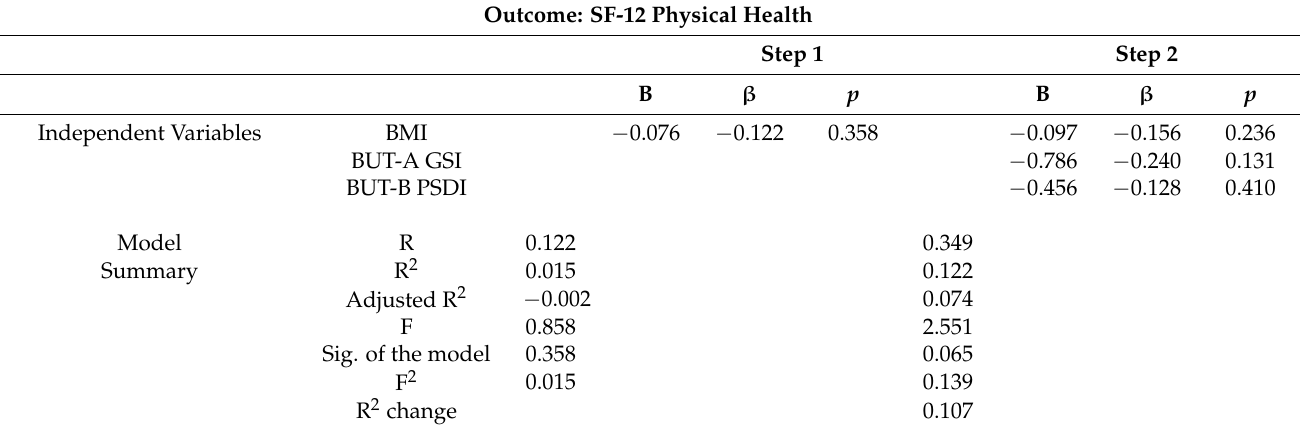
Table 5. Third hierarchical regression models including two steps, with BMI as predictor in first step; BMI, BUT-A GSI, and BUT-B PSDI as predictors of SF-12 Physical Health in second step. Outcome: SF-12 Physical